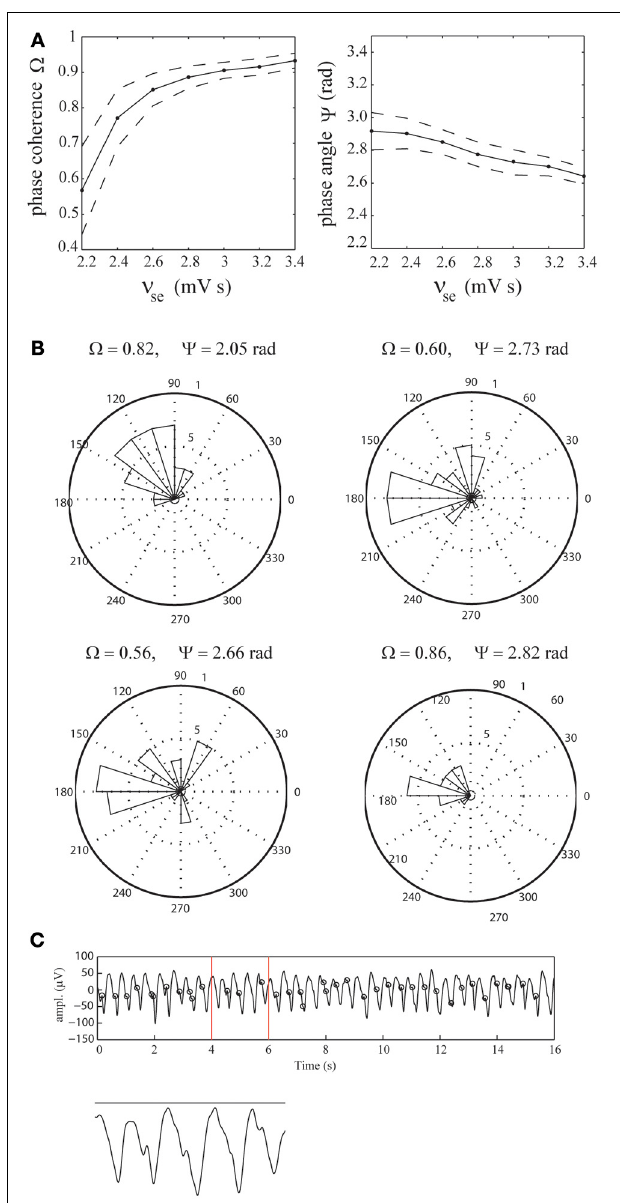
FIGURE 5 | Phase-locking of epileptic spikes. (A) Mean phase-coherence (cid:2) and phase-angle (cid:3) as a function of ν se (solid lines), respectively. The parameter ν se was increased from 2.2 to 3.4mV s in steps of 0.2mV s. For each value of ν se , the displayed values were obtained by computing the average phase-coherence and phase-angle over 100 simulations, each of length 18s. Their standard deviations are indicated by dashed lines. (B) Radial distributions of the spike-phases for the four selected EEG epochs. (C) Illustration using the first epoch. Shown is the EEG time-series and the epileptic spikes (black circles). The vertical red lines mark the time-span of the close-up. reflects stochasticity of the underlying phase-locking